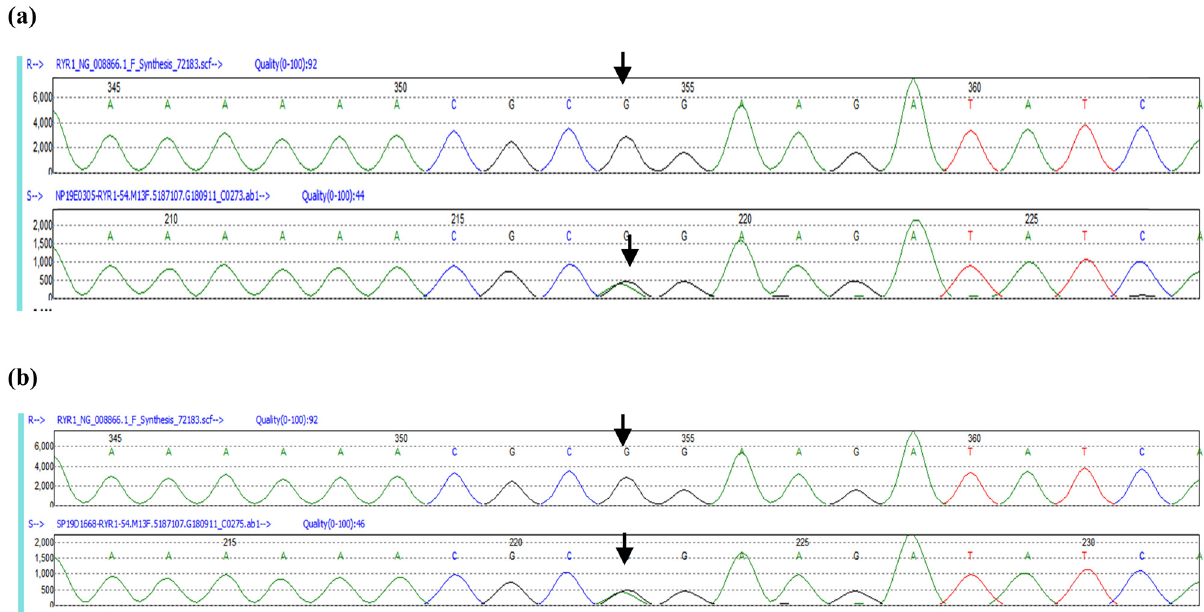
Figure 1: ( a ) The mutation in the RYR1 gene was con fi rmed by sequencing ( c.8519G > A, p.arg2840gln ) . The reference sequence is at the top, and the patient ’ s sequence is at the bottom. ( b ) The mutation in the RYR1 gene of the patient ’ s daughter was con fi rmed by sequencing ( c.8519G > A, p.arg2840gln ) . The reference sequence is at the top, and the sequence of the patient ’ s daughter is at the